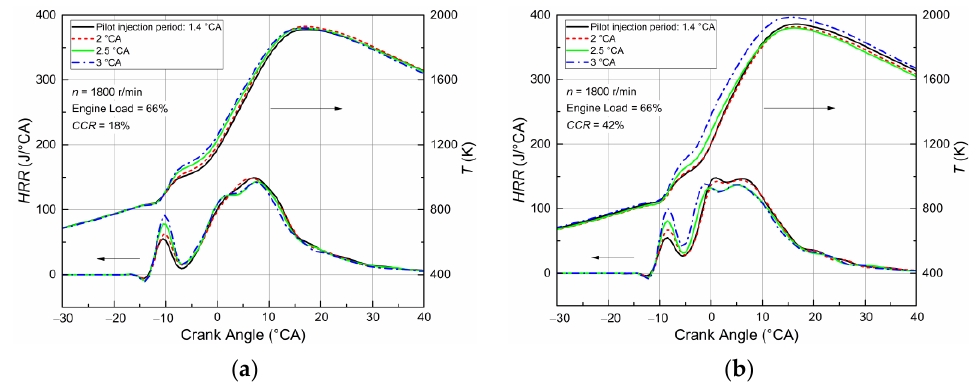
Figure 9. HRR and T under different pilot injection periods at 18% CCR ( a ) and 42% CCR ( b ).